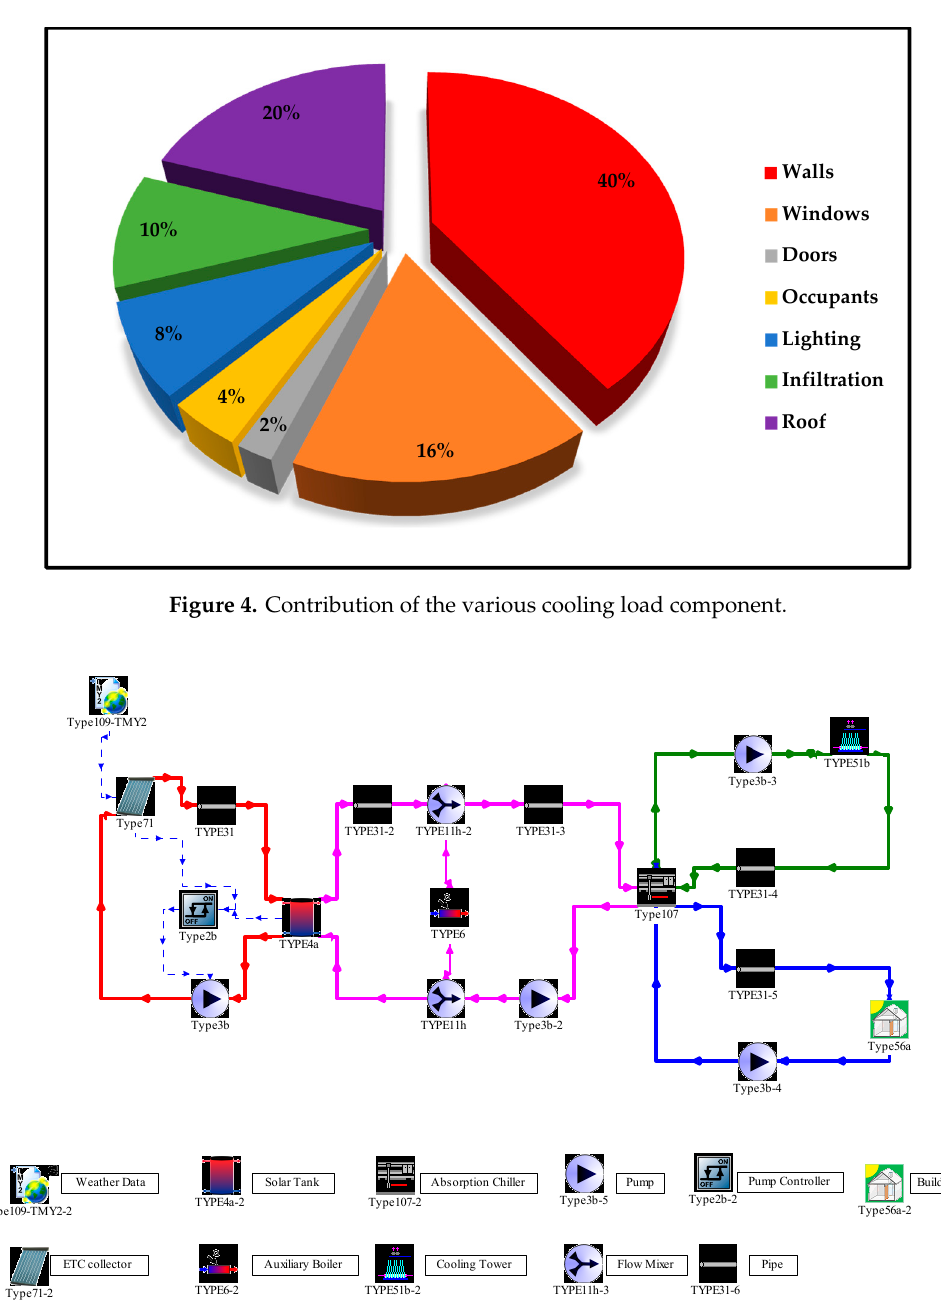
Figure 5. Diagram of the TRNSYS model of the solar absorption cooling system (SACS). Table 4. List of the most important components of the TRNSYS model.